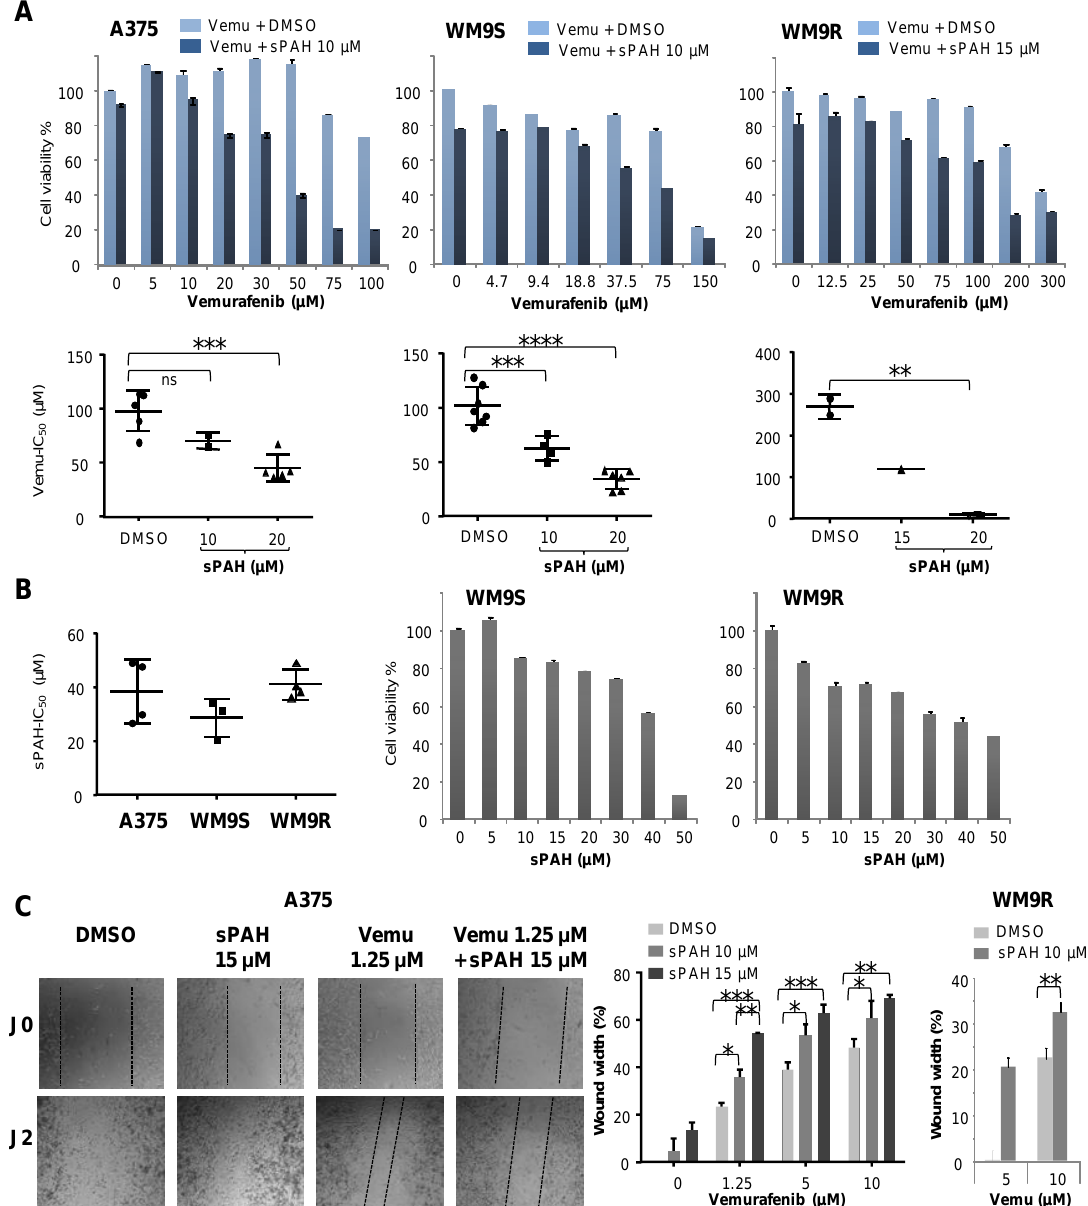
Figure 5. sPAH increases the sensitivity of BRAF V600E melanoma cells to vemurafenib. ( A ) sPAH increases vemurafenib cytotoxicity in three BRAF V600E melanoma cell lines. Cell viability was measured after treatment with increasing concentrations of vemurafenib in the presence of DMSO or sPAH in A375, WM9S, and WM9R cells. Vemurafenib IC 50 values calculated in the presence of DMSO or at various concentrations of sPAH are reported. ( B ) sPAH cytotoxicity for BRAF V600E melanoma cells. Cell viability was measured after treatment with increasing concentration of sPAH in A375, WM9S, and WM9R cells. sPAH IC 50 values are reported. ( C ) sPAH increases vemurafenib e ff ect on cell migration. After wounding, A375 or MW9R cells were treated with vemurafenib, sPAH, or vemurafenib + sPAH. Pictures were taken immediately and 48 h after wounding. The width of the wound was measured using ImageJ software and reported as a percentage of final wound width / initial wound width. All data presented are the mean ± SEM of 3 independent experiments. Significance is attained at p < 0.05 (*) (**: p < 0.005, ***: p < 0.0005); ns: no significant di ff